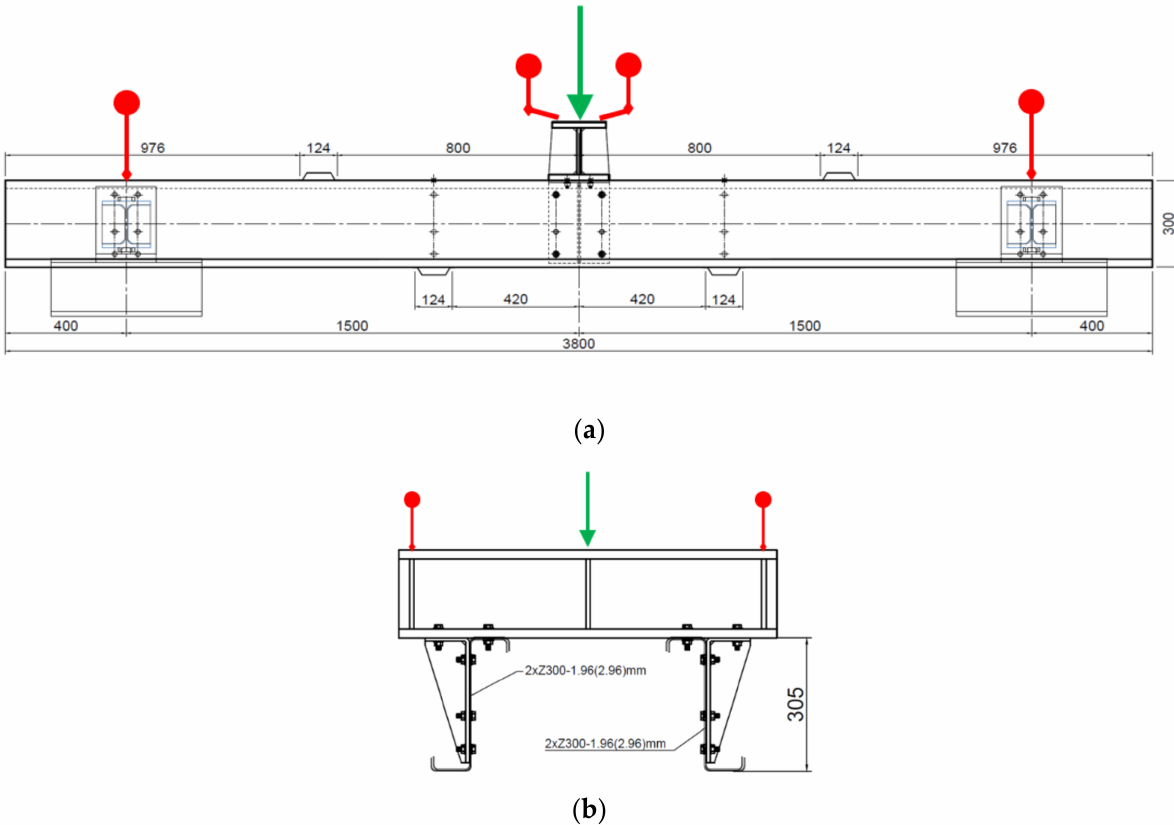
Figure 1. Scheme of the load test ( a ) a side view and ( b ) a cross-section of the location of the distribution